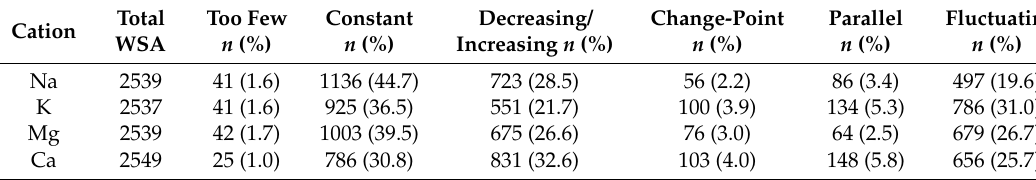
Table 4. Categorization of drinking water concentrations of Na, K, Mg and Ca at water supply area (WSA) level according to the temporal distribution ranked in trend